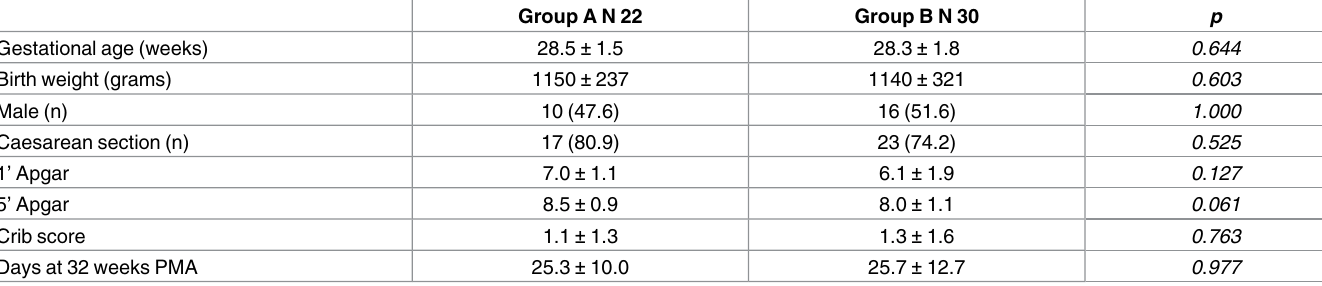
Table 1. Baseline characteristics of preterm infants in the two study groups.